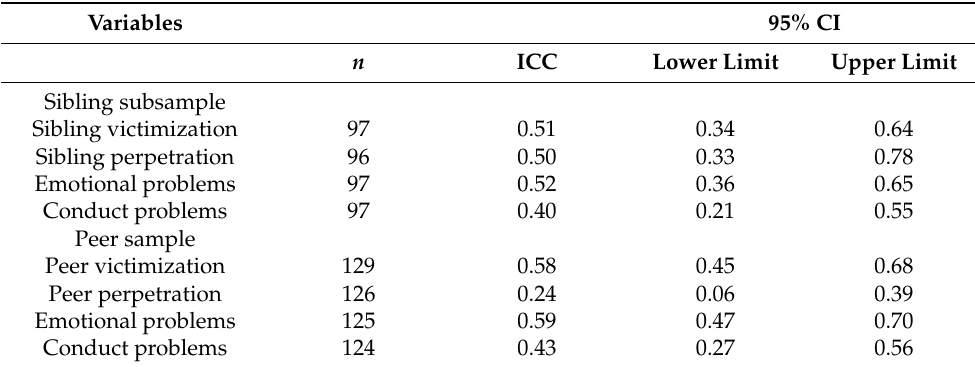
Table 4. Parent-child agreement across bullying and child